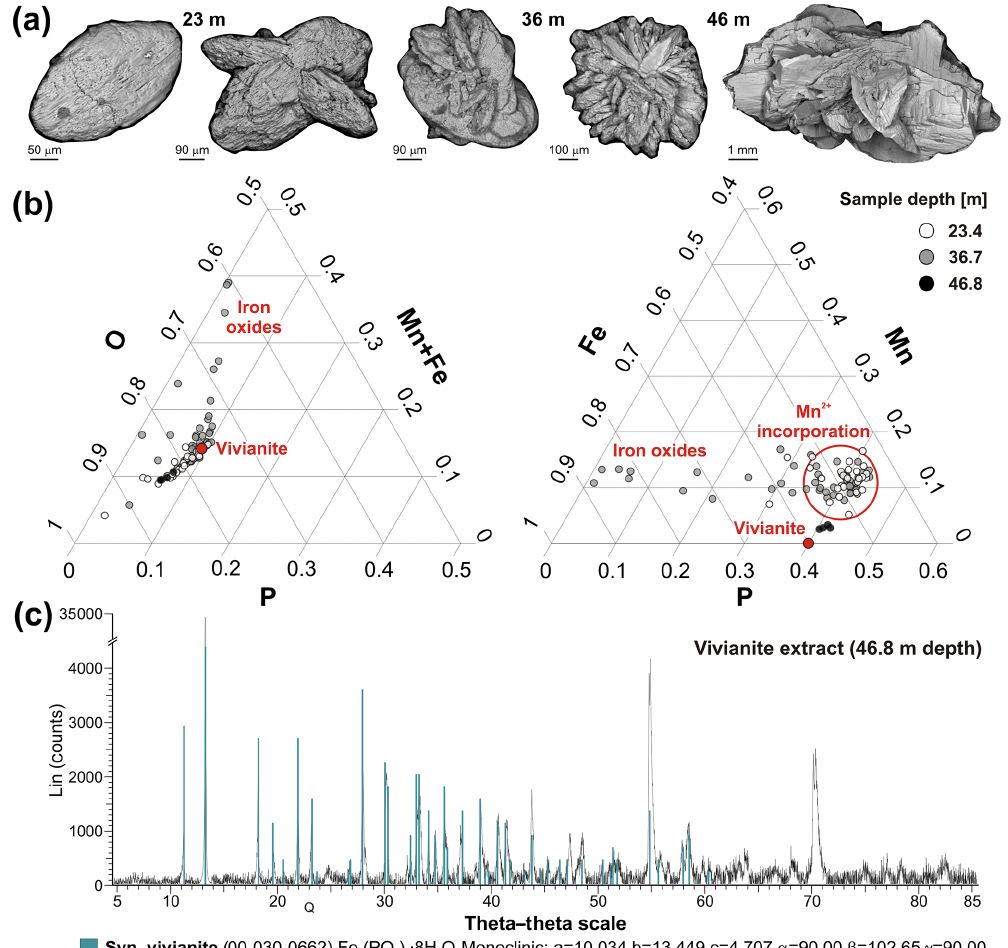
Figure 3. SEM images of vivianite crystals: ternary diagrams of EDX punctual analyses and XRD spectrum. (a) SEM images show that vivianite crystals grow from a tabular habit to rosette. (b) EDX elemental analyses (i.e., O, P, Fe, Mn) of vivianite crystals standardized to 100% for each ternary diagram. Results indicate incorporation of manganese in the vivianites with the presence of detrital iron oxides. The deepest samples plot closer to stoichiometric vivianite (red dot). (c) XRD spectrum of pure vivianite extract from 46.8m depth with reference peaks of synthetic vivianite (blue